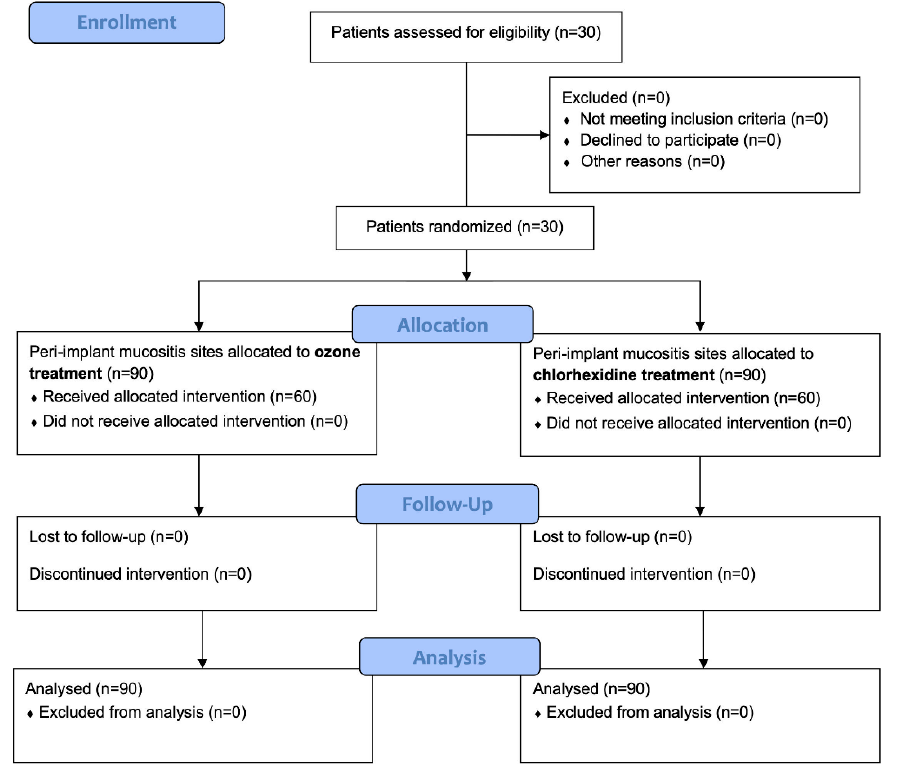
Table 3. Demographic data of the study sample at the baseline (T0).